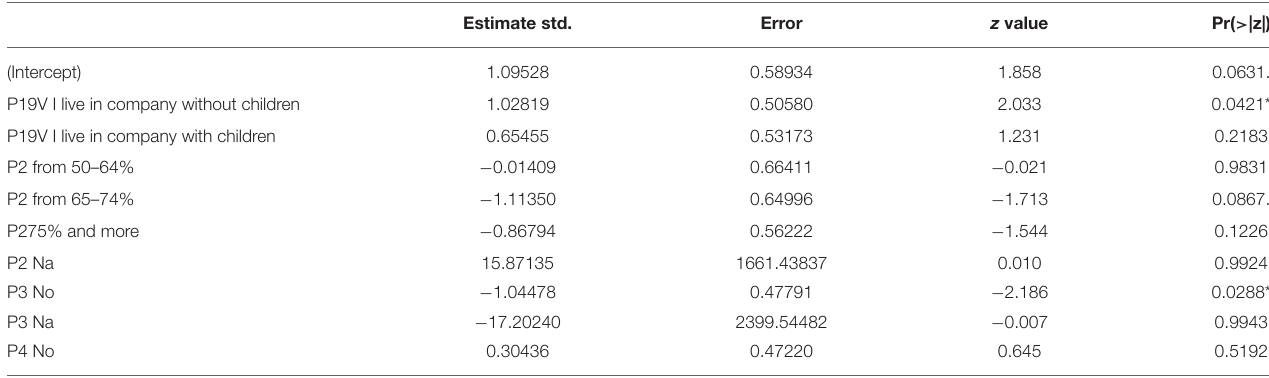
TABLE 2 | Statistical summary of logistic regression n.1 with results for all variables.